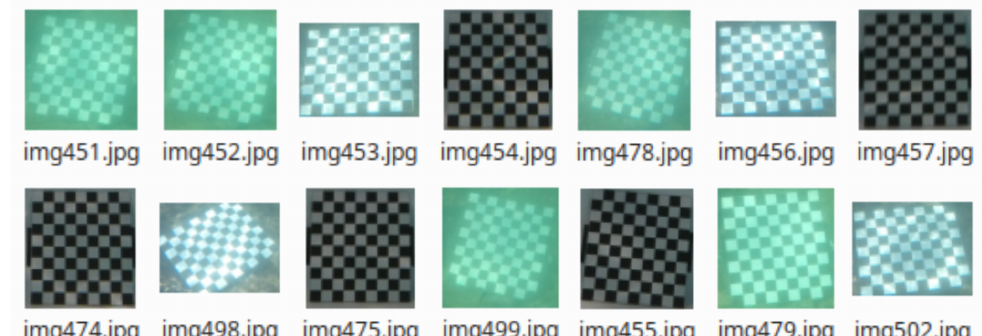
Figure 5. Focus of attention: the bounding boxes are used to automatically crop the images on the region of interest (the chessboard) to simplify the search for the intersections (anchor points).